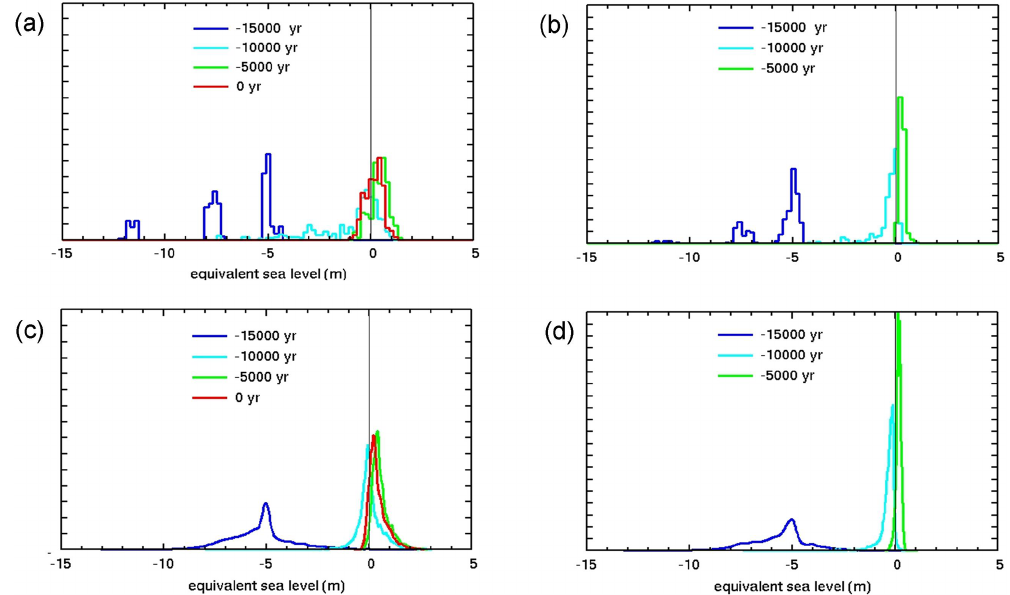
Figure 6. (a) Probability densities of equivalent sea-level (ESL) rise at particular times in the LE simulations, computed with the simple averaging method. At a given time t , the density P(E) is the sum of aggregate scores S (n) for all runs n with equivalent sea-level rise ESL (n) (t) within the bin E − 0 . 1 to E + 0 . 1m, i.e., using equispaced bins 0.2m wide. The resulting P(E) are normalized so that the integral with respect to E is 1. ESL (n) (t) are relative to modern observed Antarctica, as in Fig. 5a. (b) As (a) but with ESL (n) (t) relative to each run’s modern value, as in Fig. 5b. (c, d) Corresponding results to (a) and (b) , respectively, using the advanced statistical techniques in Chang et al. (2016) extended as described in Sect.